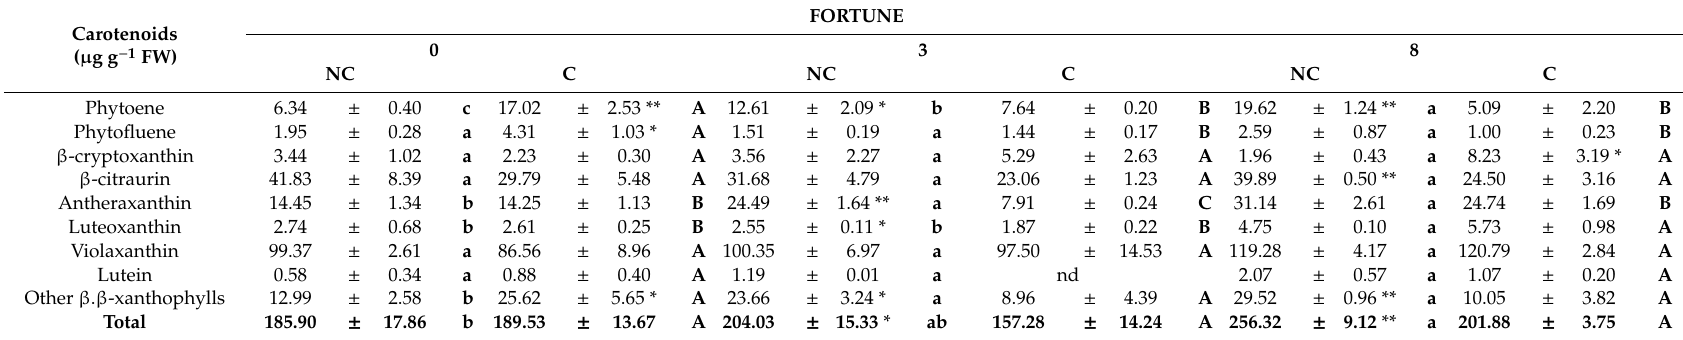
Table 1. Individual and total carotenoids ( µ g g − 1 FW) detected in the peel of non-covered (NC) and covered (C) fruit of Fortune mandarin at harvest (0) and after 3 and 8 weeks of storage at 2 ◦ C.